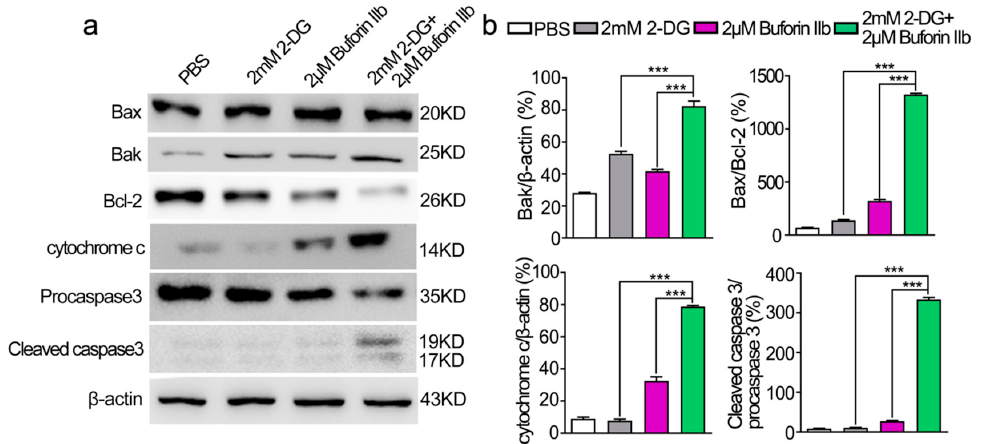
Figure 6. Effects of 2-DG and buforin IIb alone or in combination on mitochondria-dependent apoptosis in DU145 cells. ( a ) Cells pretreated with or without 2-DG (2 mM) for 12 h were incubated with buforin IIb (2 μ M) for 12 h. The lysates were harvested and apoptosis-related proteins were detected by western blotting. ( b ) The relative amounts of Bak, Bax/Bcl-2, cytochrome c, cleaved caspase 3/procaspase 3 were determined by western blotting and Image J densitometric analysis. Results are the mean ± SEM of three independent experiments. *** p <